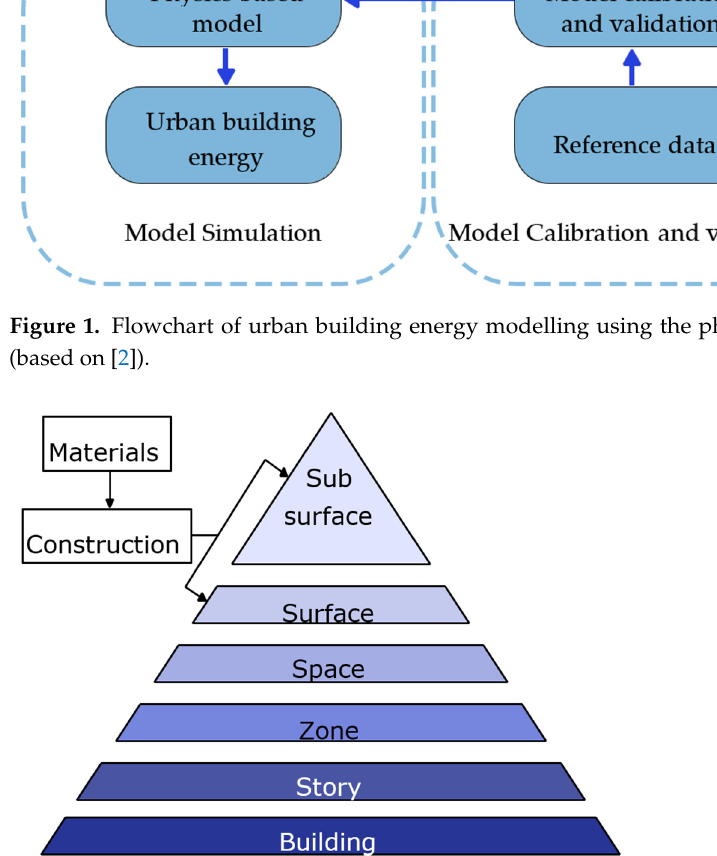
Figure 1. Flowchart of urban building energy modelling using the physics-based bottom model (based on [2]).